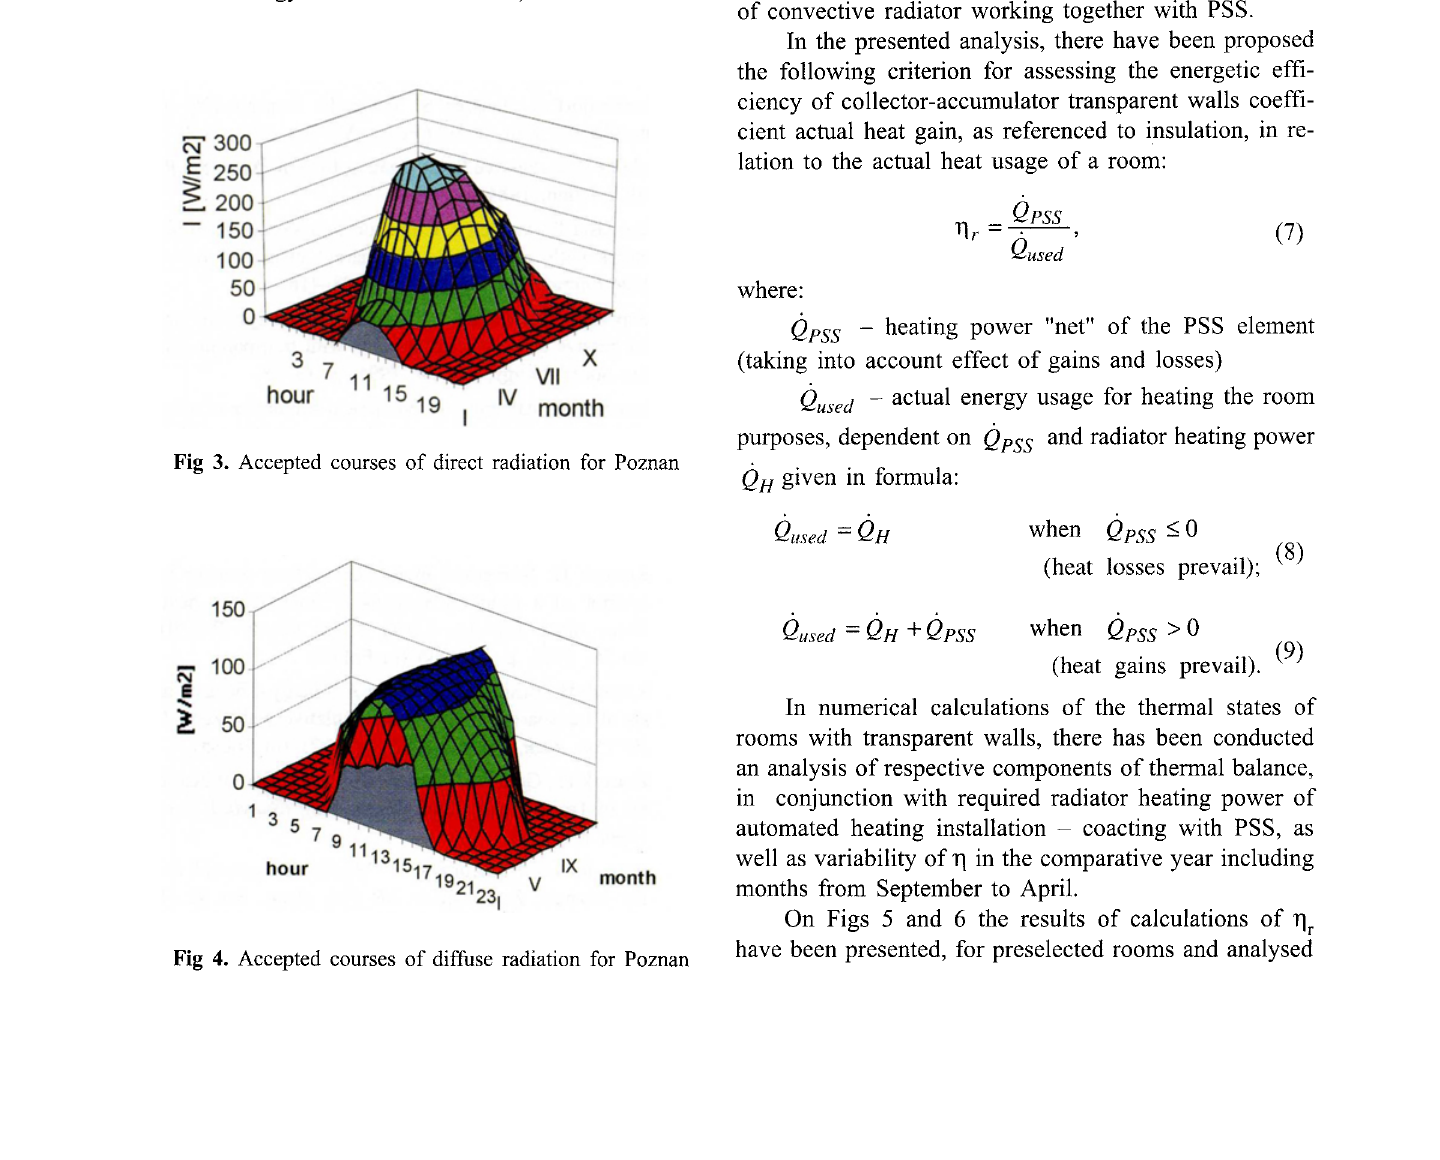
Fig 4. Accepted courses of diffuse radiation for